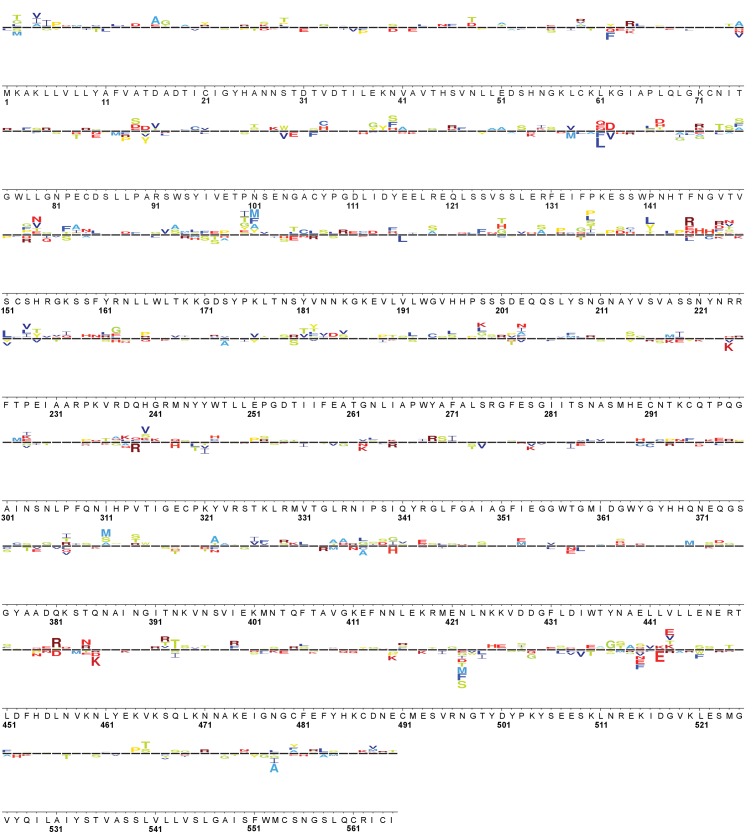
Full WSN HA sequence logo plot: ATF6f/XBP1s 39˚C vs. Basal 39˚C.Logo plot displays variants that behaved consistently across three biological replicates. Variants above the line (representative of selection on wild-type) were enriched upon ATF6f/XBP1s induction at 39˚C; variants below the line were depleted. The wild-type WSN HA residue is shown below the corresponding logo, with the sites numbered below the wild-type sequence (based on sequential numbering of WSN HA). The size of the amino acid letter abbreviation is proportional to the diffsel for that amino acid variant, and all logo plots are plotted on the same scale.